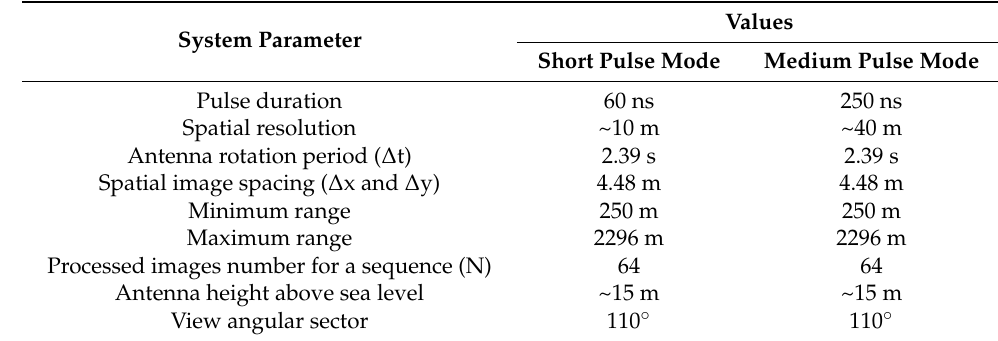
Figure 1. Point (R) indicates the position of the wave radar system in Cape Granitola site and the triangle indicates the meteorological station of the network SIAST. Table 1. Parameters of the radar survey.